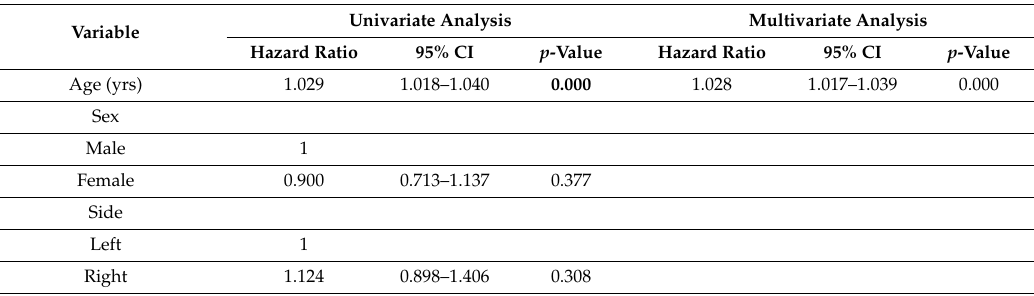
Univariate Analysis